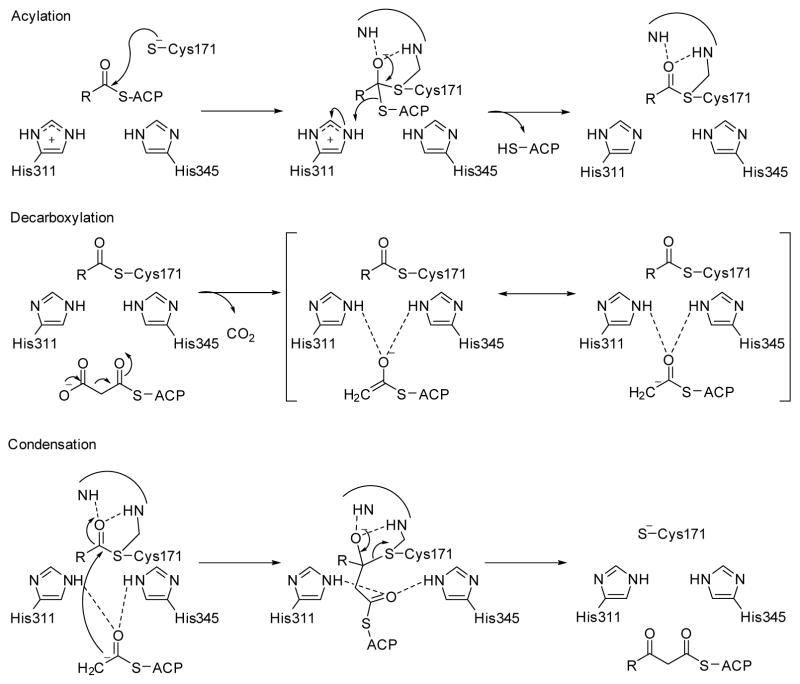
Catalytic mechanism of KasA.